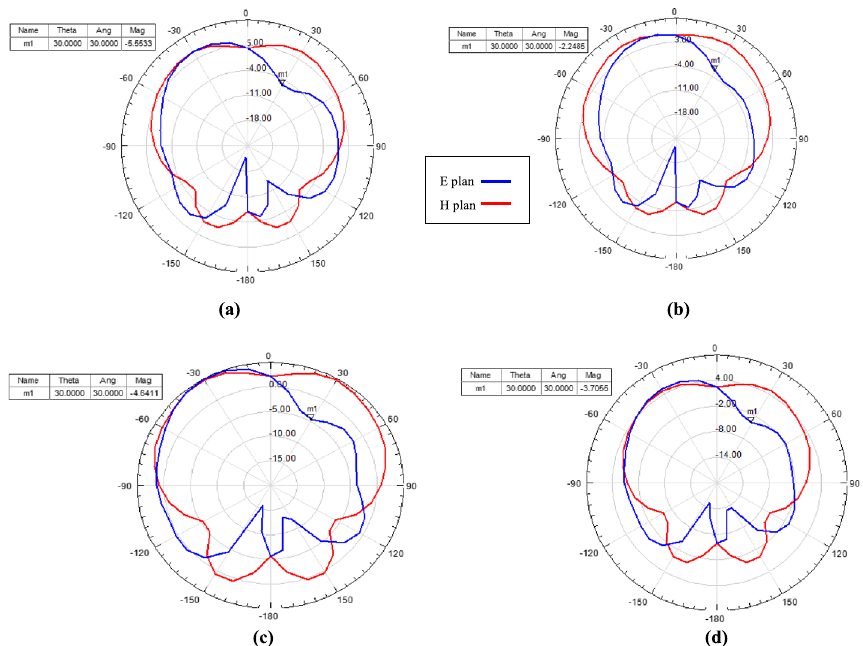
Fig. 9 The radiation pattern for the microstrip antenna with DBC-SRR structure at 0.65 THz. a Conventional antenna, b antenna with one array of DBC-SRR, c two arrays, and d three arrays